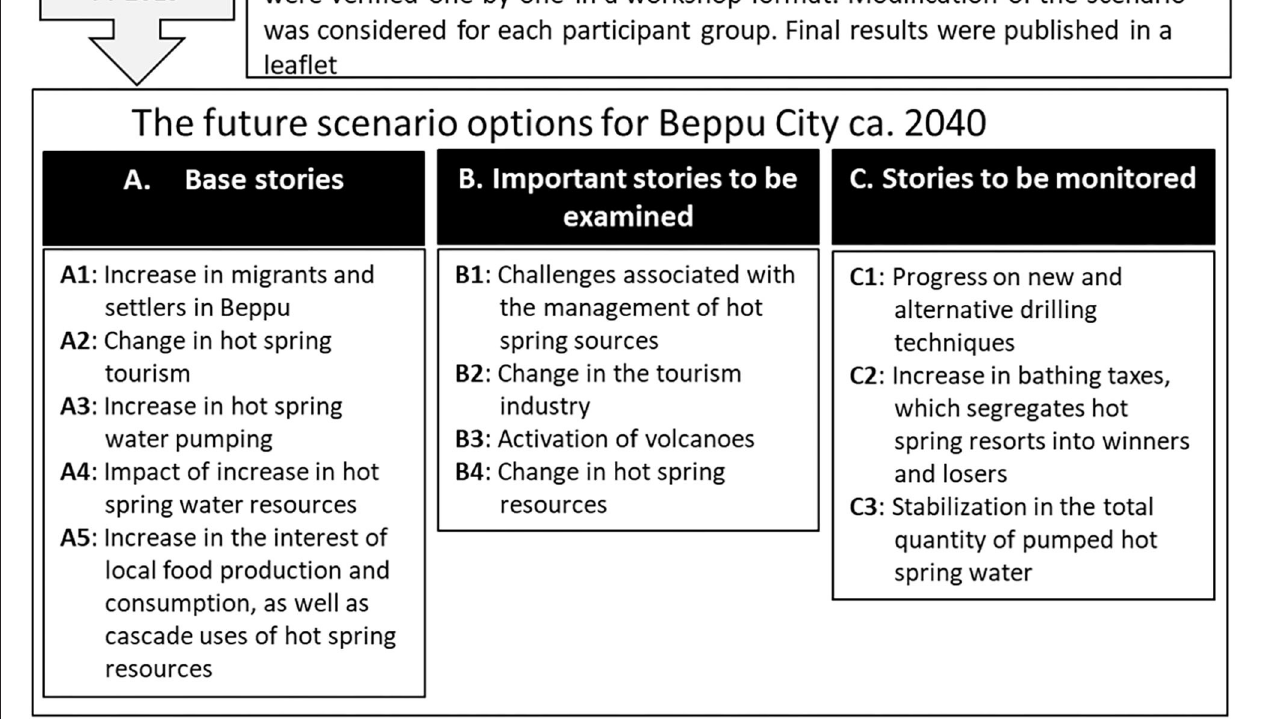
and enable them to understand the scientific interpretation process. Project researchers also gained local knowledge from the participants through mutual learning and joint